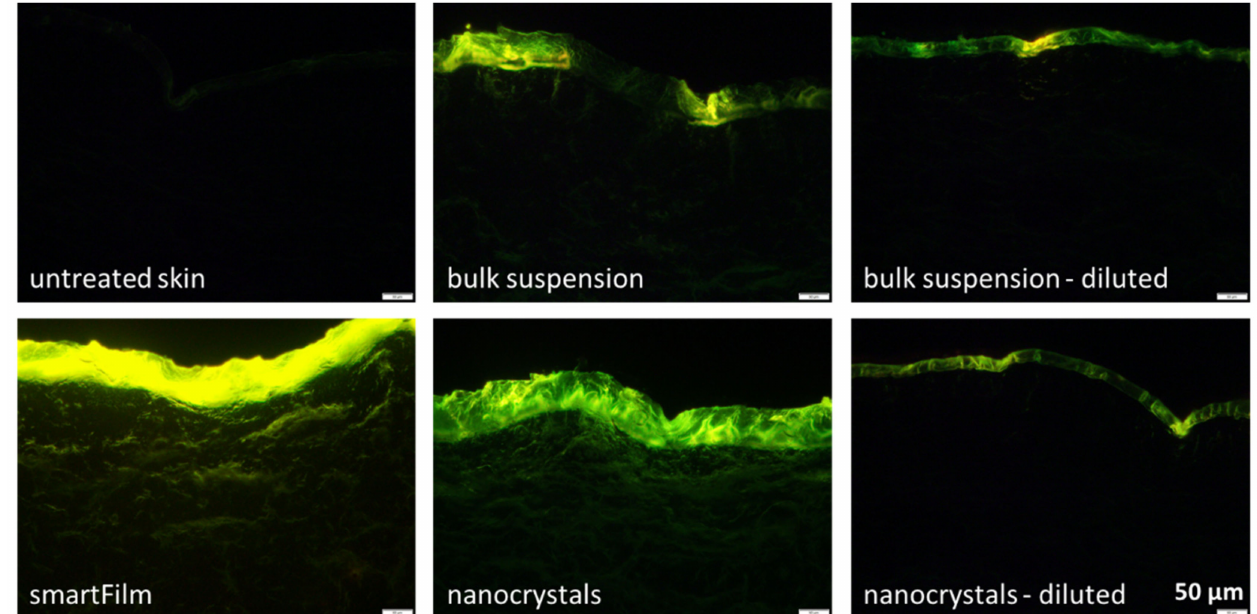
Figure 4. Comparison of dermal penetration efficacy of curcumin from bulk material, nanocrystals, smartFilms and from diluted bulk material and diluted nanocrystals to obtain similar amounts of curcumin on the skin as for the smartFilms. Im- ages (200-fold magnification) were obtained by epifluorescence microscopy from punch biopsies of porcine ears (penetration time for the formulations was 6 h at 32 ◦ C: for more details—c.f. Supplementary Materials